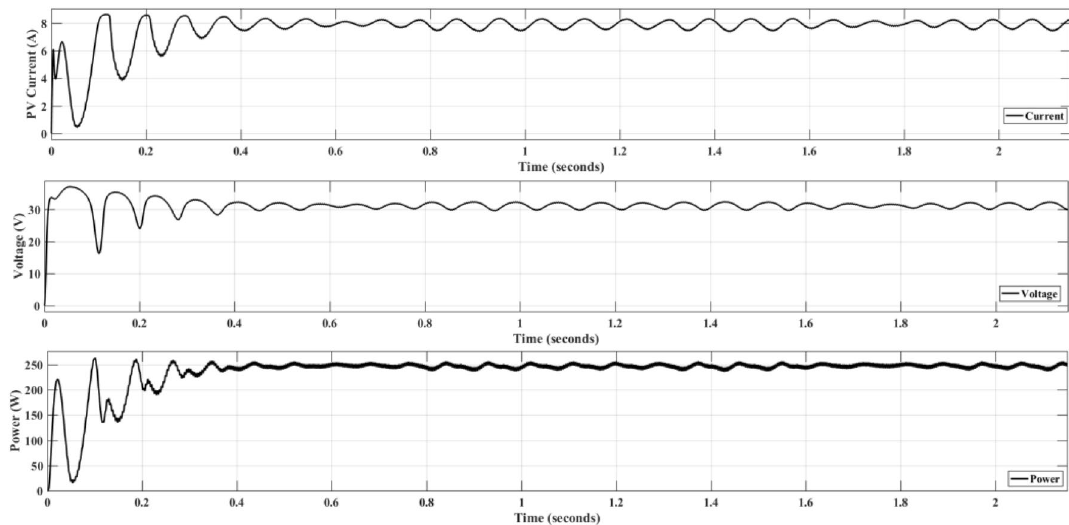
Fig. 5 Current, voltage and power of photo voltaic panel for maximum power point